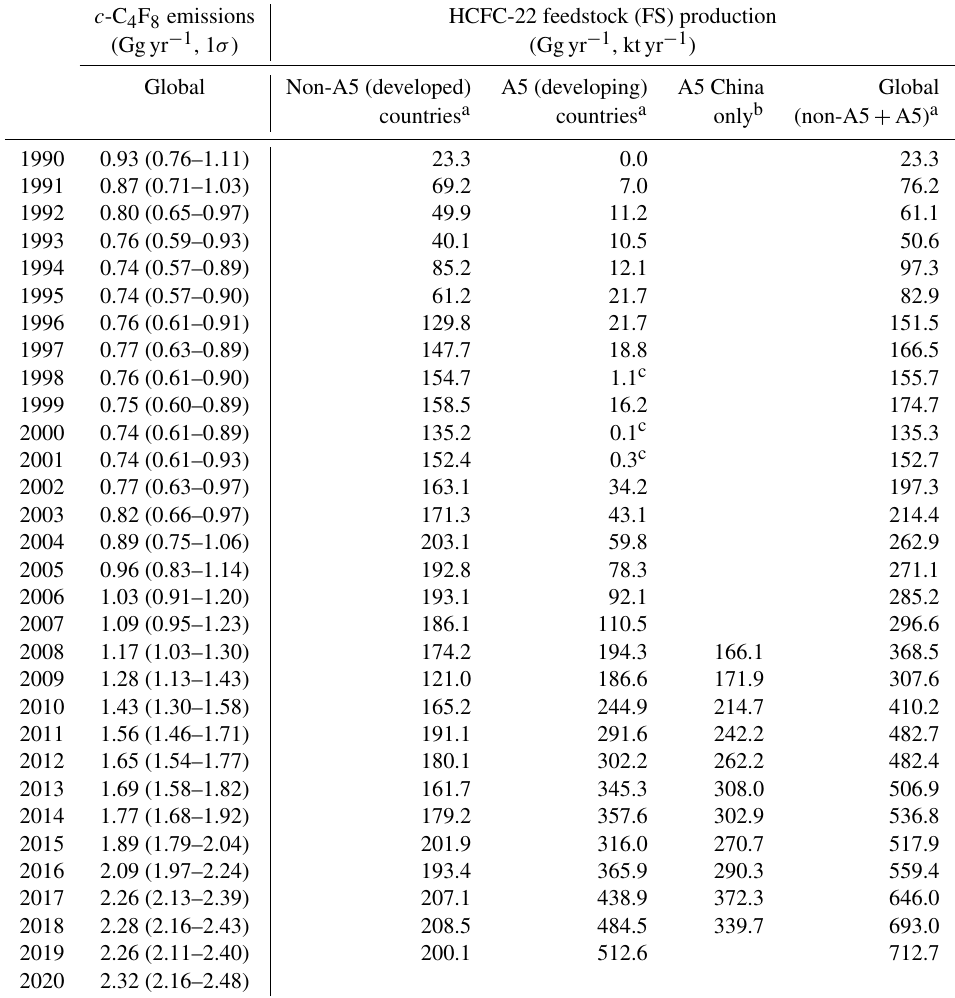
Table 1. Global c -C 4 F 8 emissions determined from AGAGE atmospheric measurements and hydrochlorofluorocarbon-22 (HCFC-22) feed- stock (FS) production from United Nations Environment Programme (UNEP) and Technology and Economic Assessment Panel (TEAP) reports. Most of HCFC-22 feedstock (FS) production in developing (A5) countries occurs in